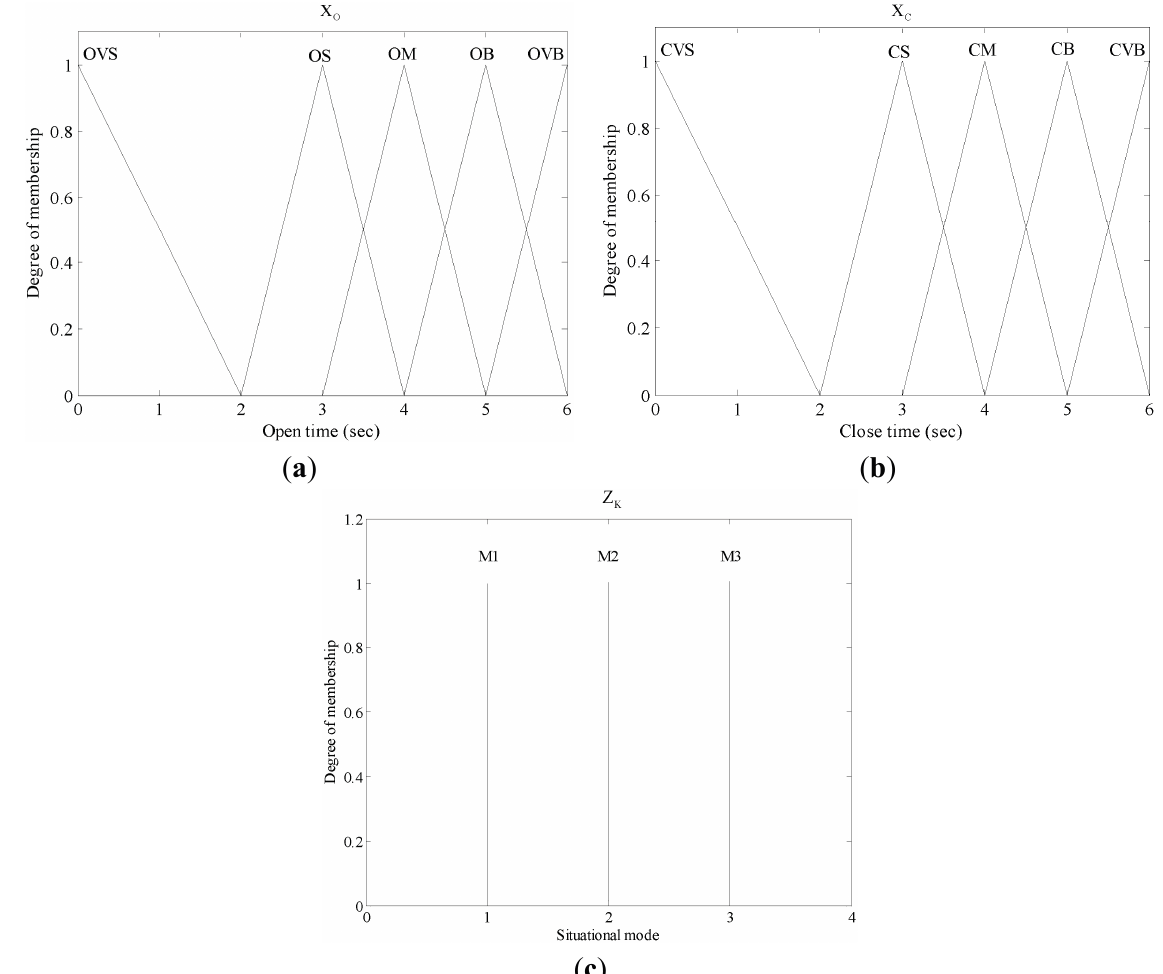
Figure 6. Input and output membership functions of fuzzy main controller: ( a ) membership function of open time fuzzification; ( b ) membership function of close time fuzzification; ( c ) membership function of situational mode controller